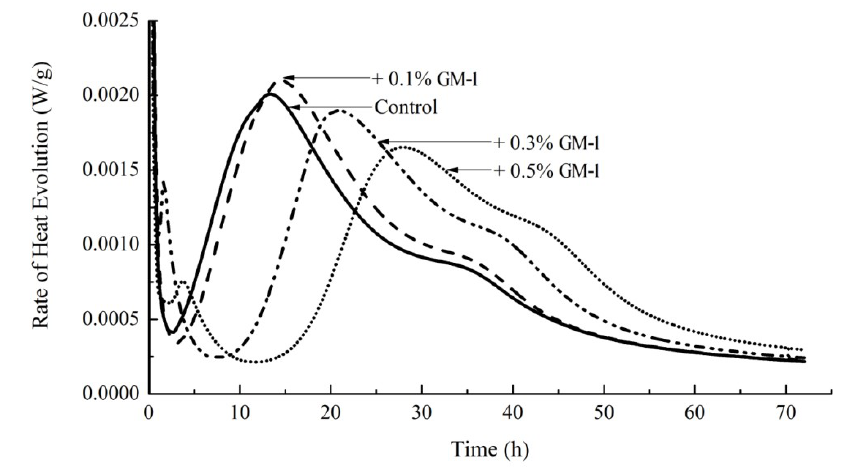
Figure 7. Hydration kinetics of cement paste containing GM-1at proportions of 0.1%, 0.3%, and 0.5% of the mass of cement.